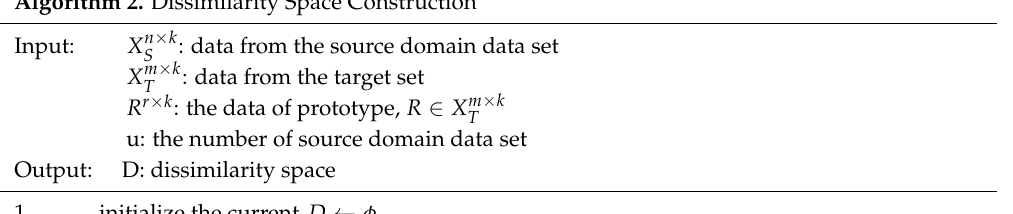
Algorithm 2. Dissimilarity Space